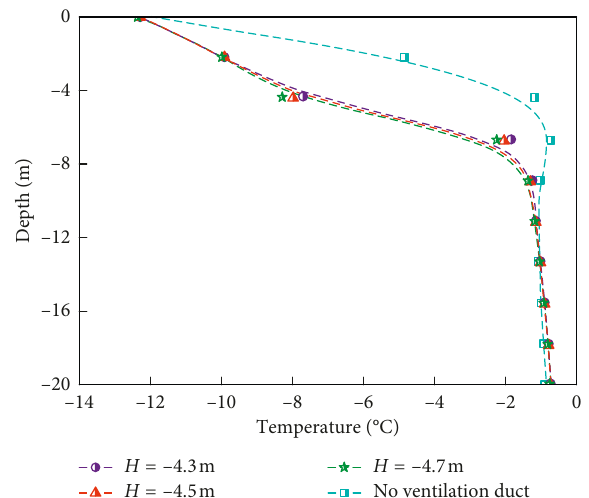
Figure 10: Annual mean temperature in the footing centrelines on January